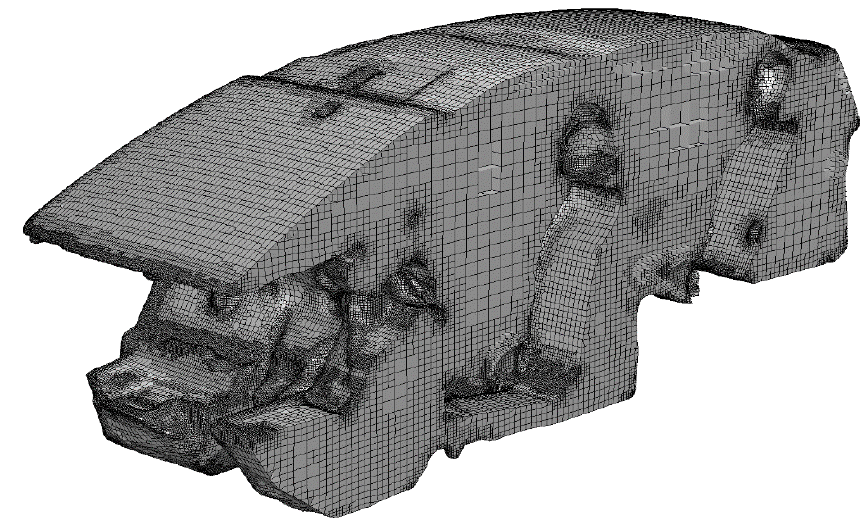
Figure 5. Ansys Fluent computational model of the case study.